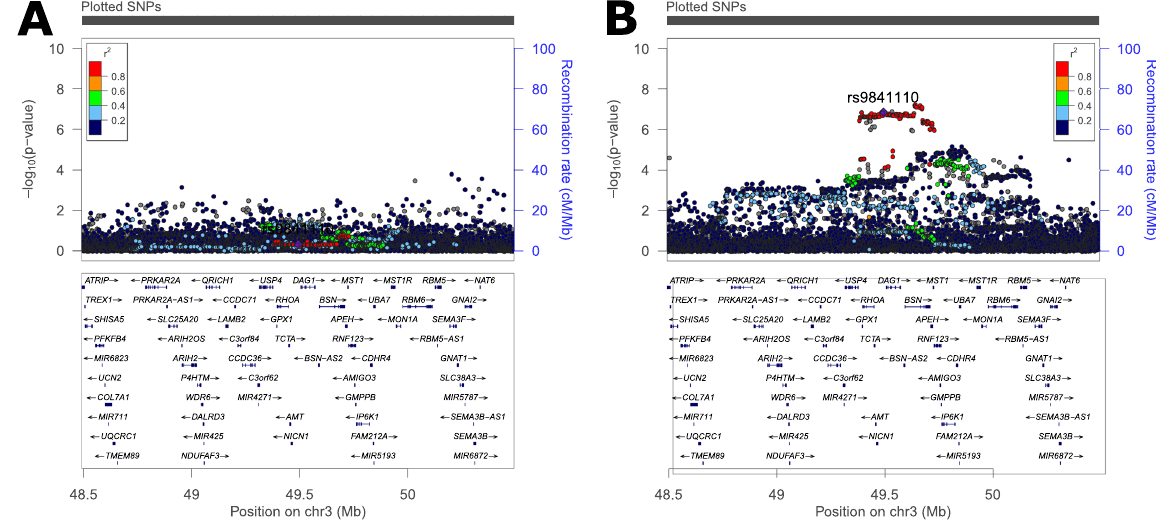
Figure 5. Plot of region on chromosome 3 identified as having a sex-specific association with GBM for ( A ) males and ( B ) females.